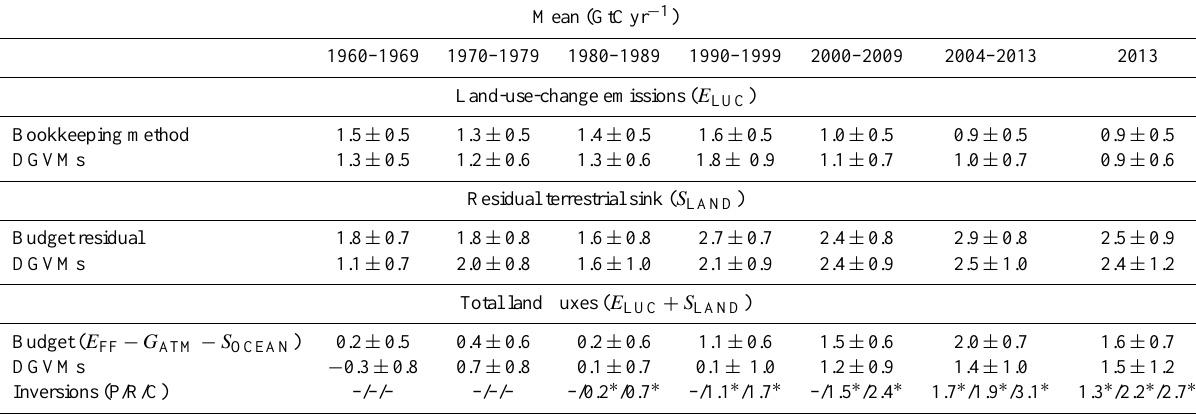
Table 7. Comparison of results from the bookkeeping method and budget residuals with results from the DGVMs and inverse estimates for The DGVM uncertainties represents ± 1 σ of results from the nine individual models; for the inverse models all three results are given where